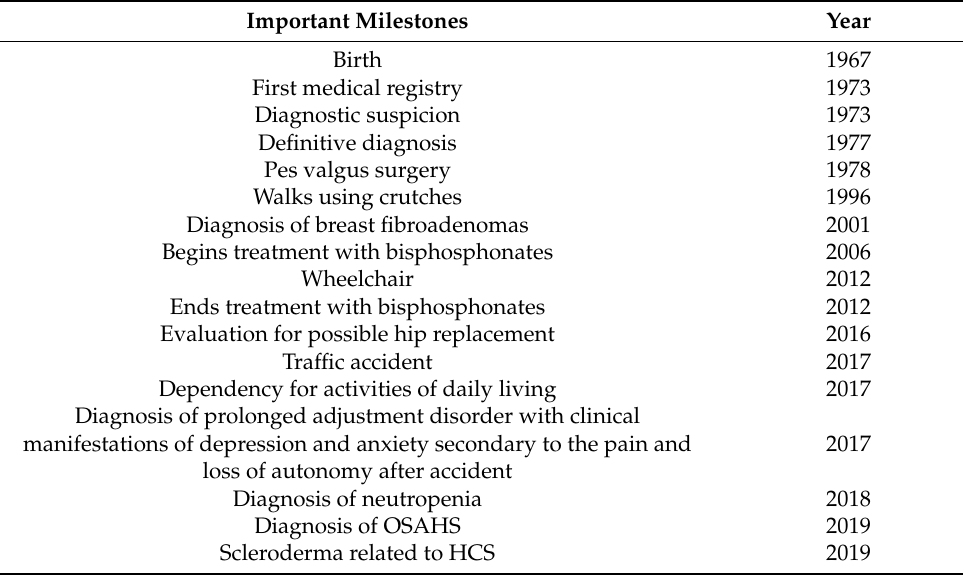
Table 3. Main milestones in the description of the